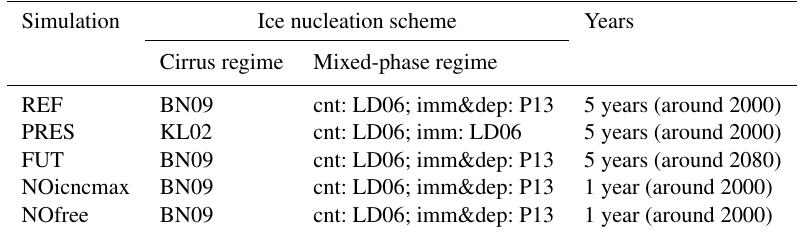
Table 3. Simulations carried out and analysed in this study. The abbreviations “cnt”, “imm”, and “dep” stand for contact nucleation, immer- sion, and deposition nucleation,